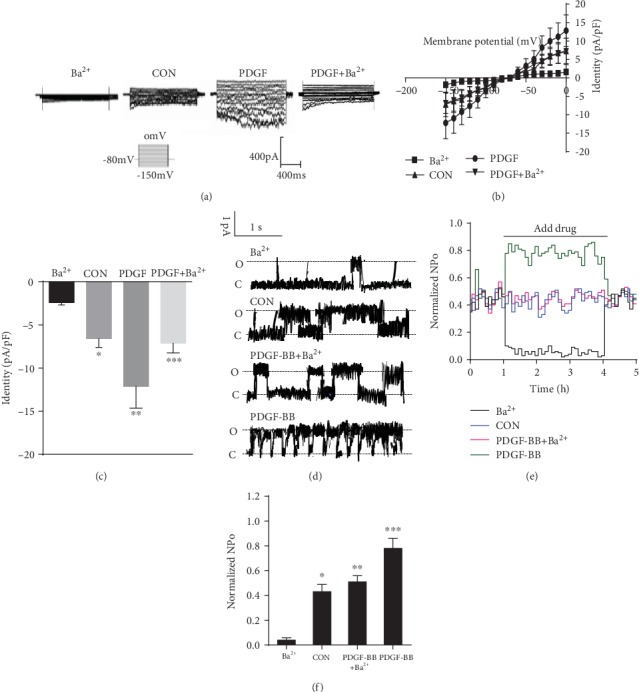
Effects of PDGF-BB on Kir2.x currents. (a) Original tracings illustrating currents determined in RASMCs. Membrane potential (Em) was held at -80 mV, and pulse potentials were applied from -150 mV to 0 mV. (b) Arithmetic mean ± SEM (n = 10) of current-voltage relationship curves. (c)Arithmetic mean ± SEM (n = 10) of the current amplitude at -150 mV of Kir2.x currents in Ba2+; CON. ∗P < 0.05 vs. Ba2+; PDGF-BB ∗∗P < 0.05 vs. CON; PDGF-BB+Ba2+. ∗∗∗P < 0.05 vs. PDGF-BB. (d) The “O” and “C” indicate the opened and closed states of Kir2.x currents, respectively. (e) Ba2+ attenuated and PDGF-BB increased the NPo of Kir2.x currents (at +70 mV) by 4.58 ± 0.33% and 78.82 ± 8.05% (∗∗P < 0.01 vs. CON, n = 5) compared to CON (43.29 ± 6.42%) (∗P < 0.01 vs. Ba2+, n = 5), and PDGF-BB+Ba2+ was 41.47 ± 6.13% (P < 0.01 vs. PDGF-BB, n = 5). (f) Time course of PDGF-BB action of Kir2.x currents. Averaged NPo plot (5 s bins) from five repeated perfusions of indicated compounds were normalized to control. CON means vascular smooth muscle cells without any drug intervention.